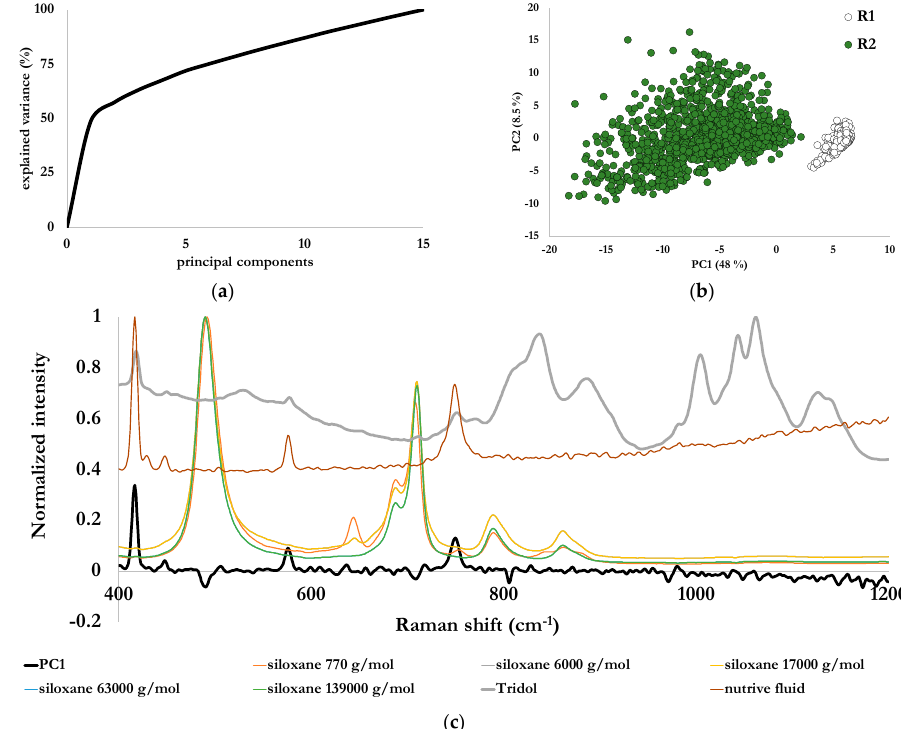
Figure 7. Explained variance ( a ), scores plot for the first two principal components ( b ) and loadings ( c ) for a PCA conducted on Raman spectra (after baseline correction and Singular Normal Variate (SNV)) obtained from measurements in reactors 1 and 2 during the biodegradation process of Tridol